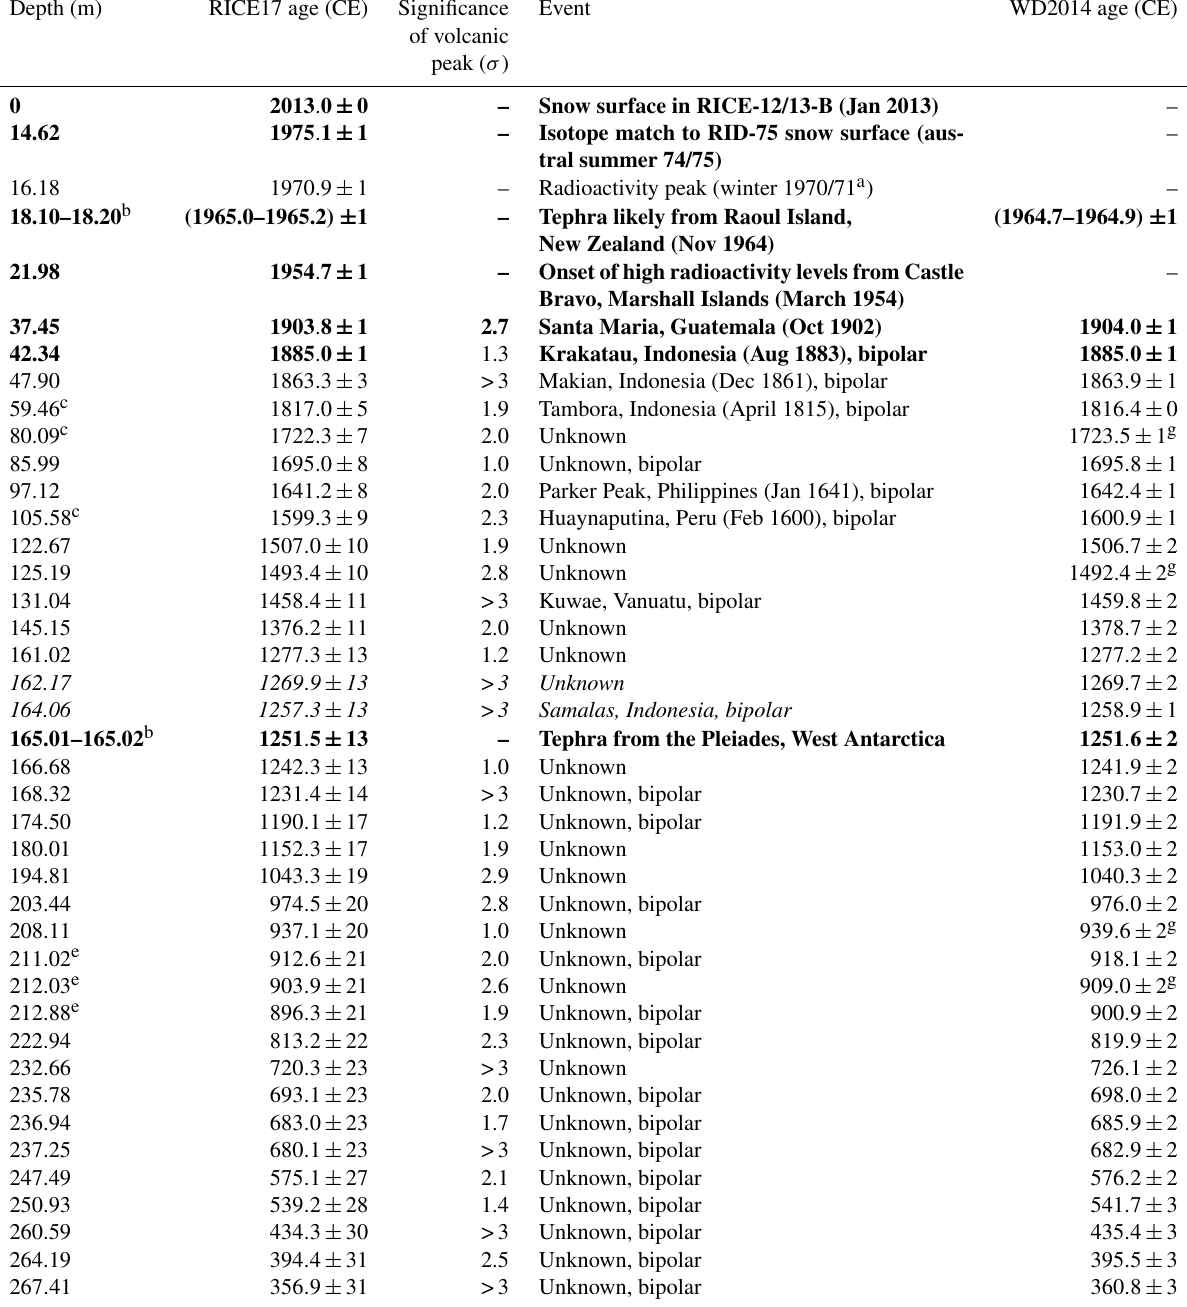
Table 2. Marker horizons used for development and validation of the RICE17 chronology. Strata in bold were used for constraining the timescale. The statistical significance of volcanic peaks in RICE (column 3) is given in terms of the average peak size in smoothed and standardized versions of the four volcanic records (ECM, H + , nss cond, nss S; down to 249m) computed relative to a running mean and standard deviation. Volcanic matching to WAIS Divide allows for comparison between RICE17 ages (with 95% confidence interval indicated) and the corresponding WD2014 ages with associated uncertainties (Sigl et al., 2015, 2016). Indicated depths and ages correspond to peaks in the volcanic proxies. Below 42.3m, decimal ages have been calculated assuming BC to peak on 1 January. Historical eruption ages (column 4) indicate the starting date of the eruption. Column 4 also indicates whether the eruption has previously been observed to cause a bipolar signal based on the compilation in Sigl et al. (2013), here updated to the WD2014 timescale. Since this compilation only identifies bipolar volcanoes back to 80CE, volcanoes prior to this are not classified. Three exceptionally large volcanic signals observed in the RICE core are indicated in